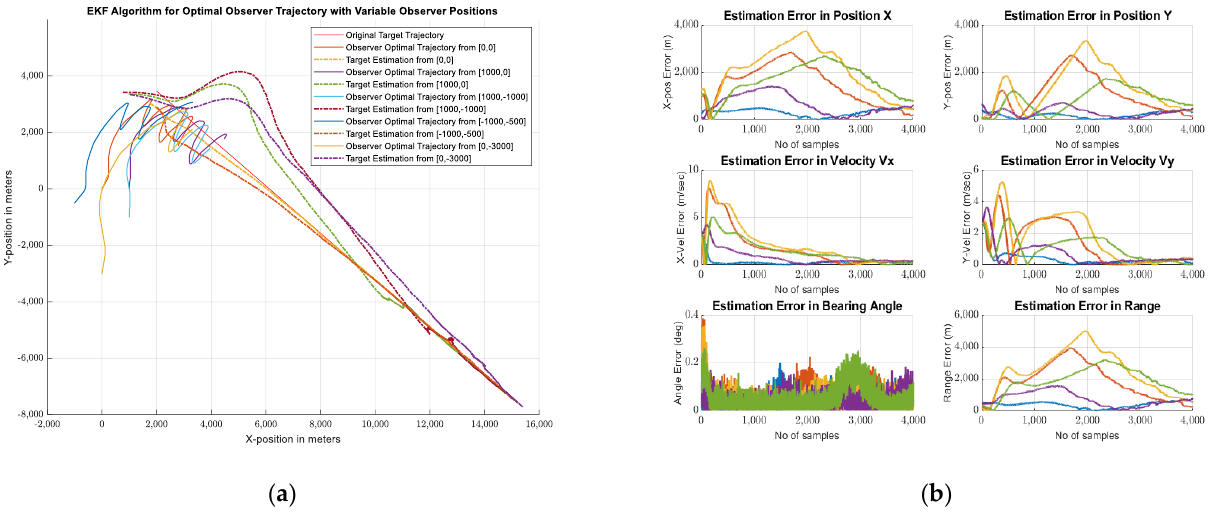
Figure 5. ( a ) Estimated Trajectories for Variable Initial Positions of Observer using EKF and; ( b ) Estimated Errors for Position, Velocity, Range, Bearing Angle for Optimal Observer path. The estimation errors for optimal observer maneuver using the ECM matrix alongside the FIM matrix are calculated separately and mentioned in Table 2 for comparison based on an EKF based estimation algorithm. The numerical results for position and velocity estimation errors at final sampling time show 3% less percentage of errors for ECM based optimization as compared with the determinant of the FIM